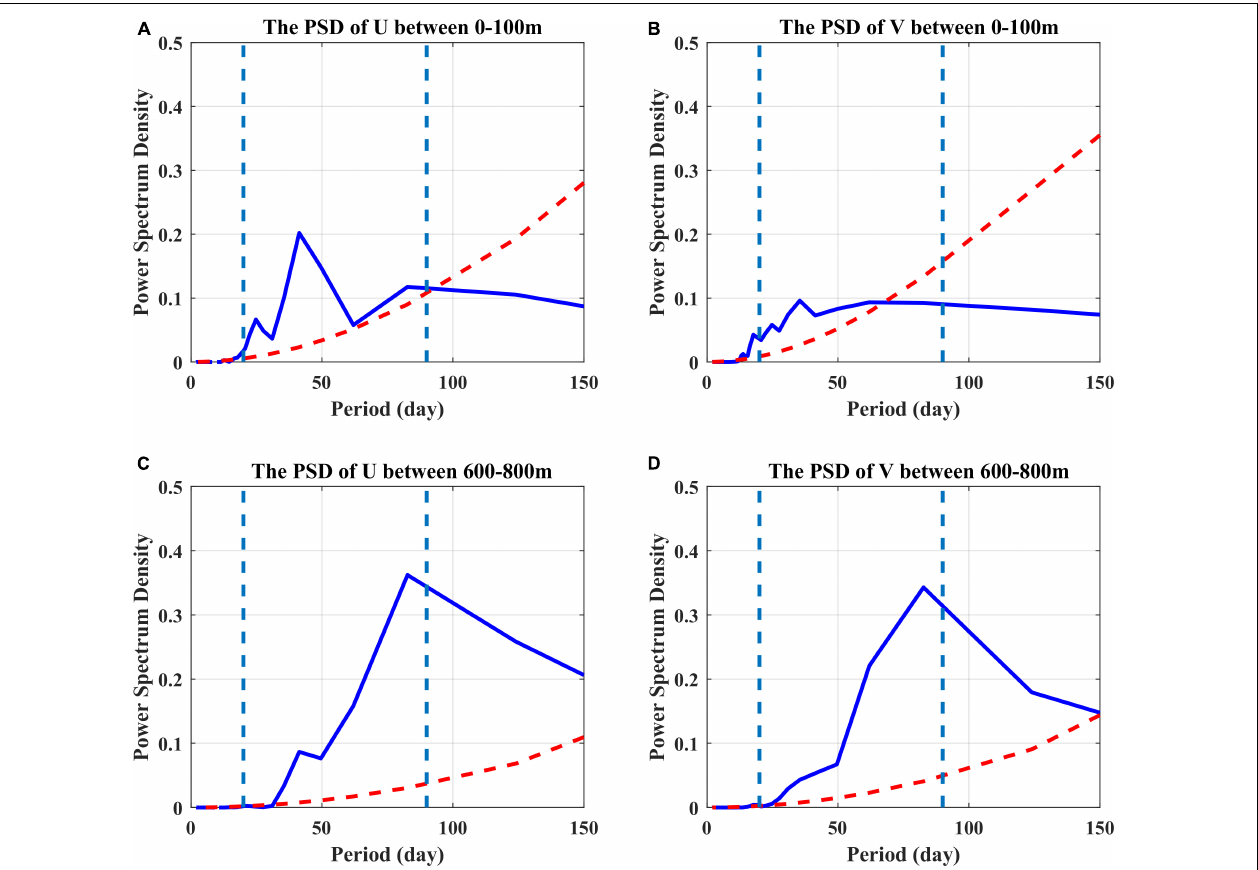
FIGURE 3 | Power spectral density of the zonal (left) and meridional (right) velocity time series averaged between 0–100 m (A,B) and 600–800 m (C,D) derived from the mooring ADCP. The red dashed curves denote the 95% significance level, and the light blue dashed lines denote the period of 20- and